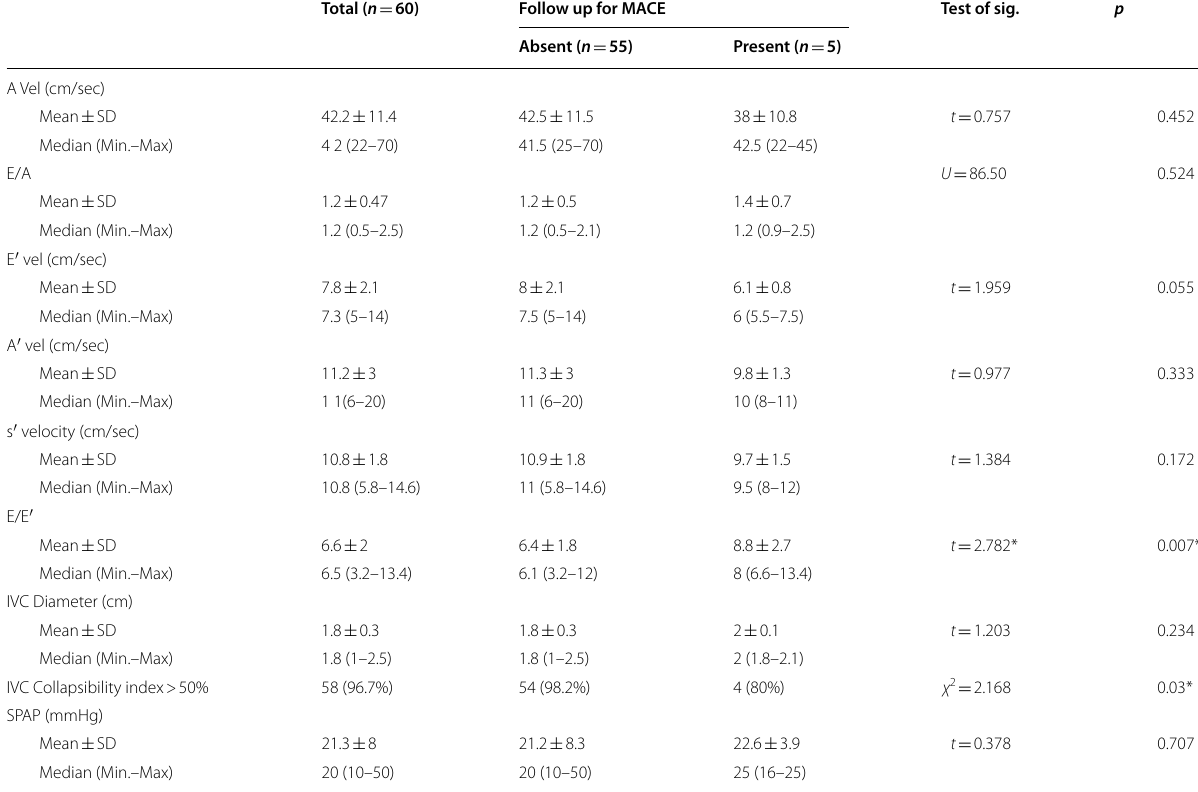
Table 3 Relation between E ′ vel and E/E ′ with Follow up for MACE ( n 60) =